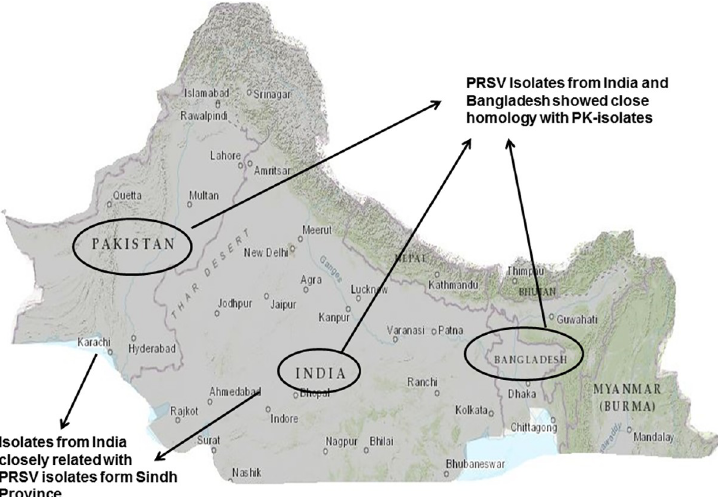
Fig 7. Map showing the isolates of PRSV–P of Pakistan compared on the basis of coat protein sequence showed close homology to Bangladesh isolates and some of the Indian isolates.